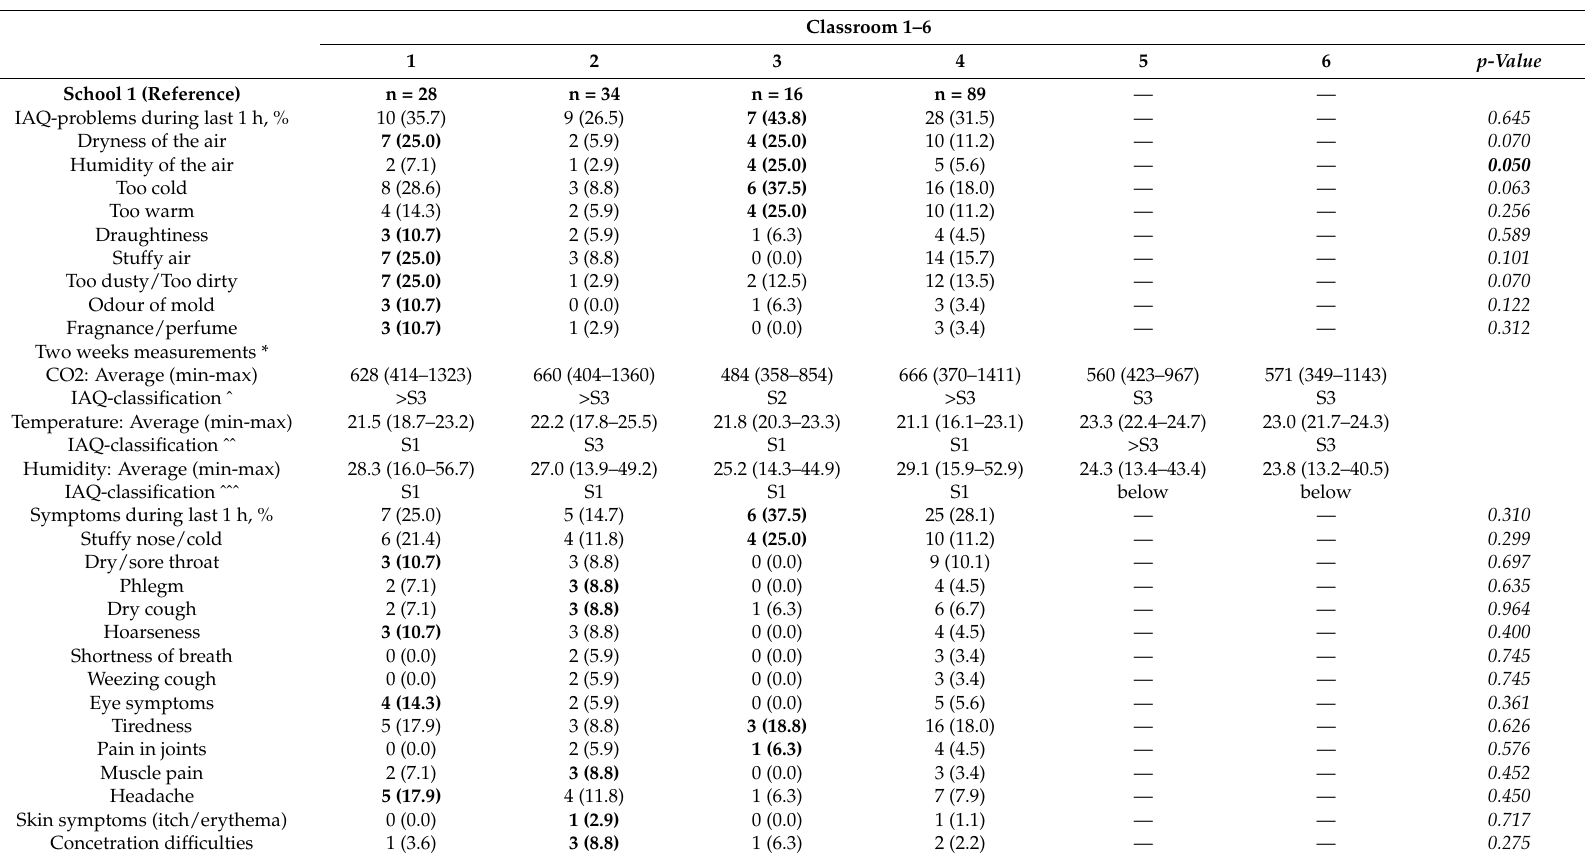
Table 4. Differences between the classrooms in the IAQ problems and symptoms during the last hour among pupils, and the results of CO 2 , temperature, and relative humidity measurements in school